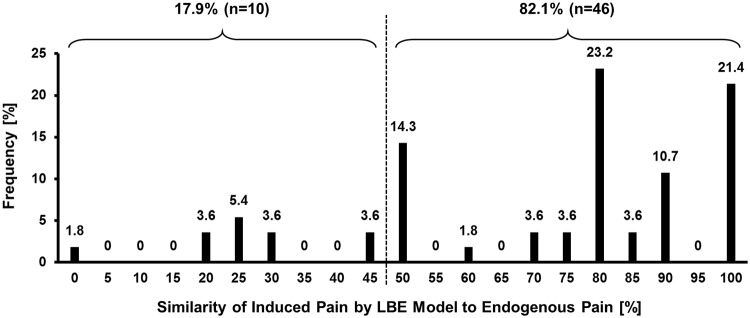
Histogram of the similarity of induced pain to clinical pain.Fifty-six subjects indicated similarity of the induced pain to their own clinical pain, and the average similarity was 69.02 ± 26.17%. Forty-six respondents (82.1%) said their induced pain was more than 50% similar to their own pain. The rest of the respondents (n = 10, 17.9%) stated that their experimental pain was less than 50% similar to their own pain.